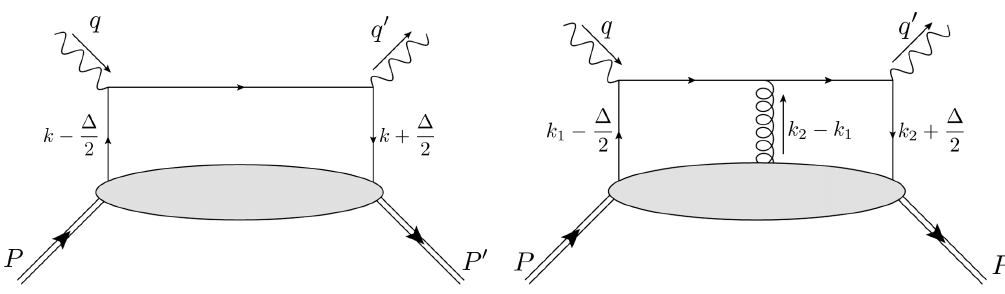
Figure 2 . Examples of twist-two (left) and twist-three (right) handbag diagrams that contribute to the twist-three Compton tensor. Other diagrams that are related to them by permutation are not shown